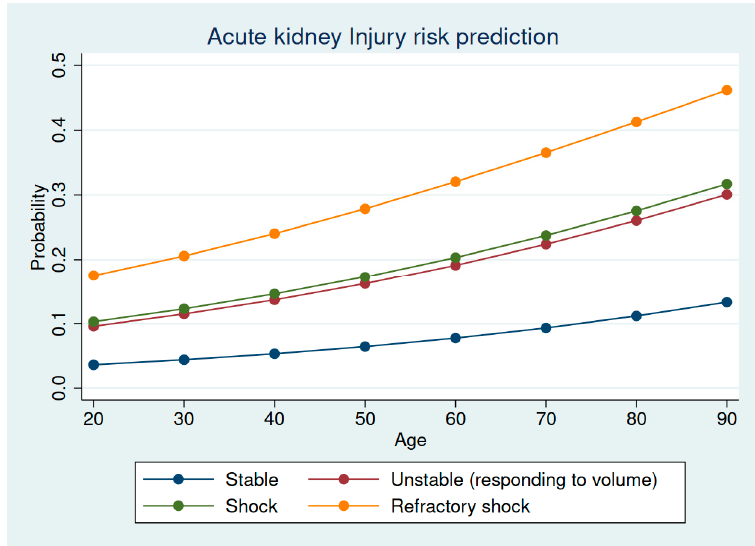
Figure 1. Mortality rate according to the development of AKI in TBI patients. RIFLE: Risk, Injury, Failure, Loss of kidney function and End-stage kidney disease. The risk factors associated with the development of AKI in isolated significant TBI patients are shown in Table 3. The probability of developing AKI was strongly associated with age and the initial hemodynamic response (Figure 2).